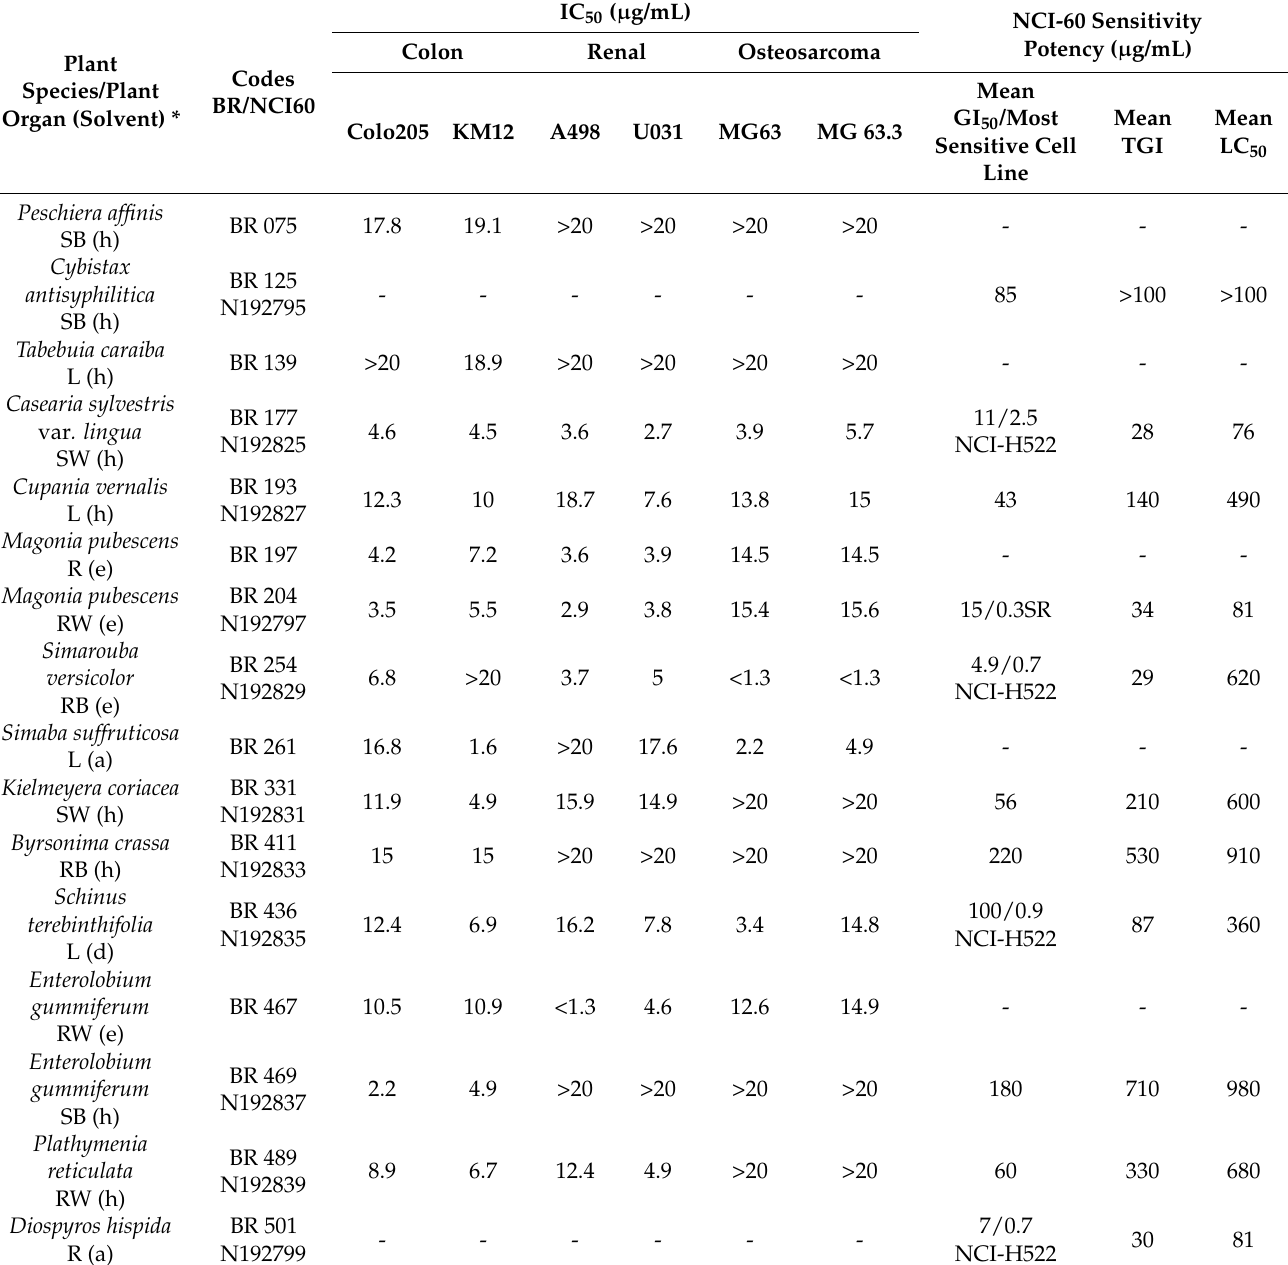
Table 1. Brazilian Cerrado plant extract activity against cancer cell lines (IC 50 µ g/mL) and NCI-60 sensitivity (potency in µ